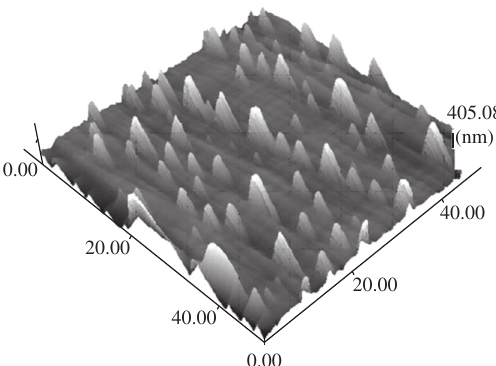
-CaO-P O film heated at 200 °C for 2 2 5